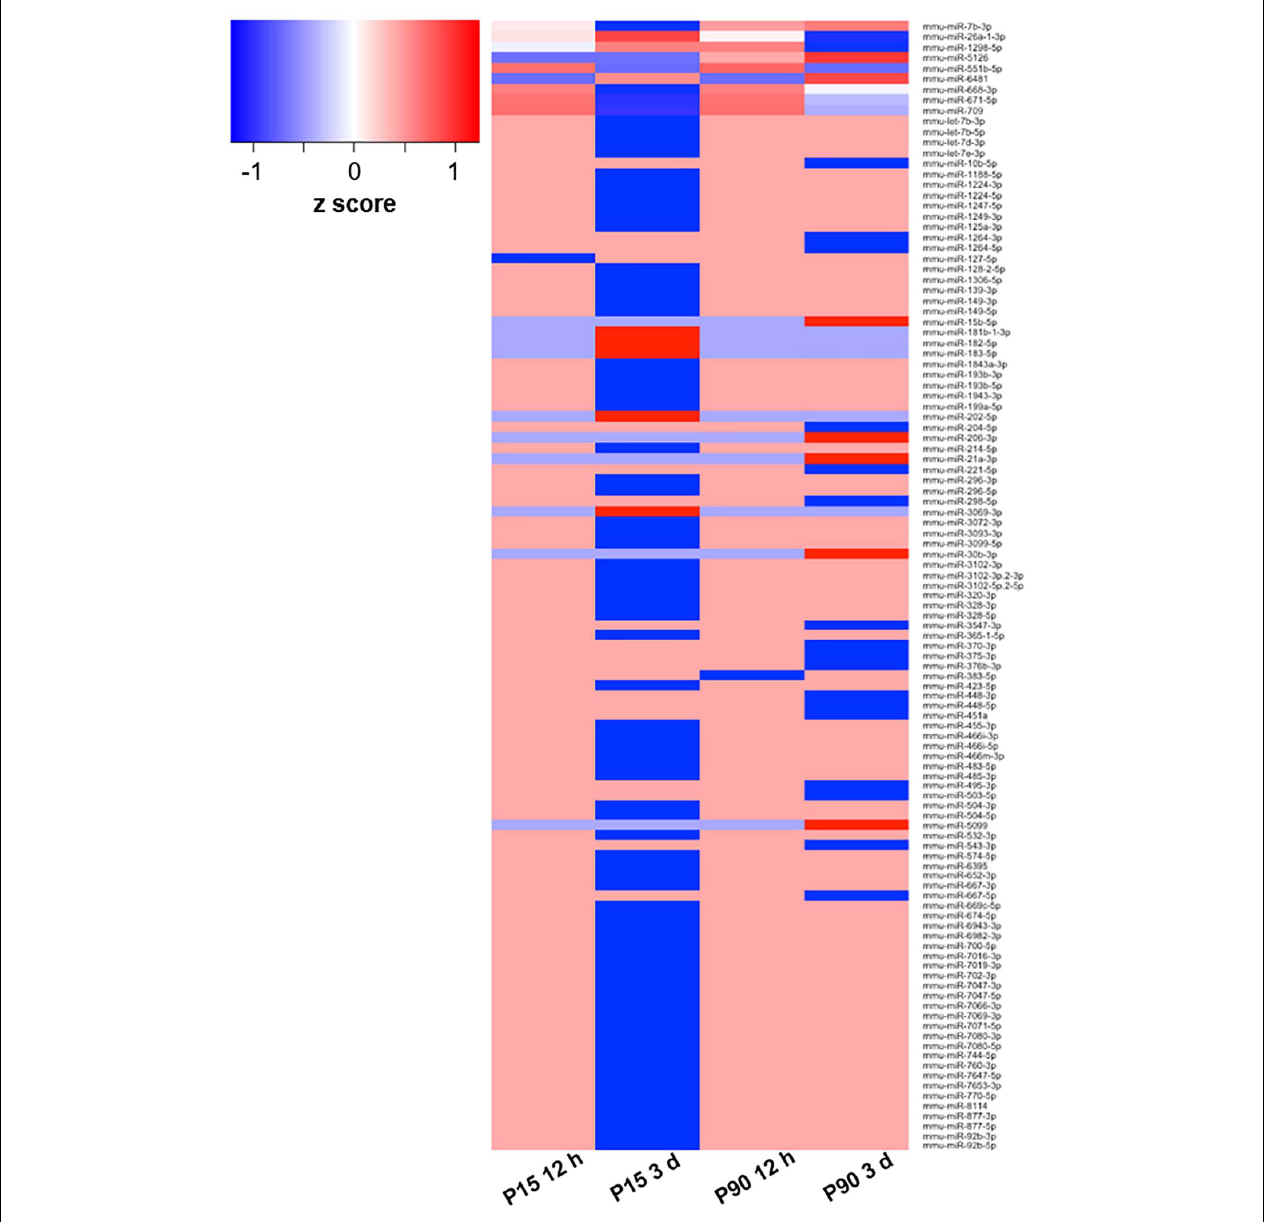
FIGURE 1 | Deregulated miRNA after SCI. Heat map based on log 2 fold change values of 110 DE miRNAs in at least one of the comparisons between cohorts (P15 12 h, P15 3 days, P90 12 h, P90 3 days) plus corresponding controls. The z -score represents the deviation from the mean by standard deviation units; n = 3 for each experimental